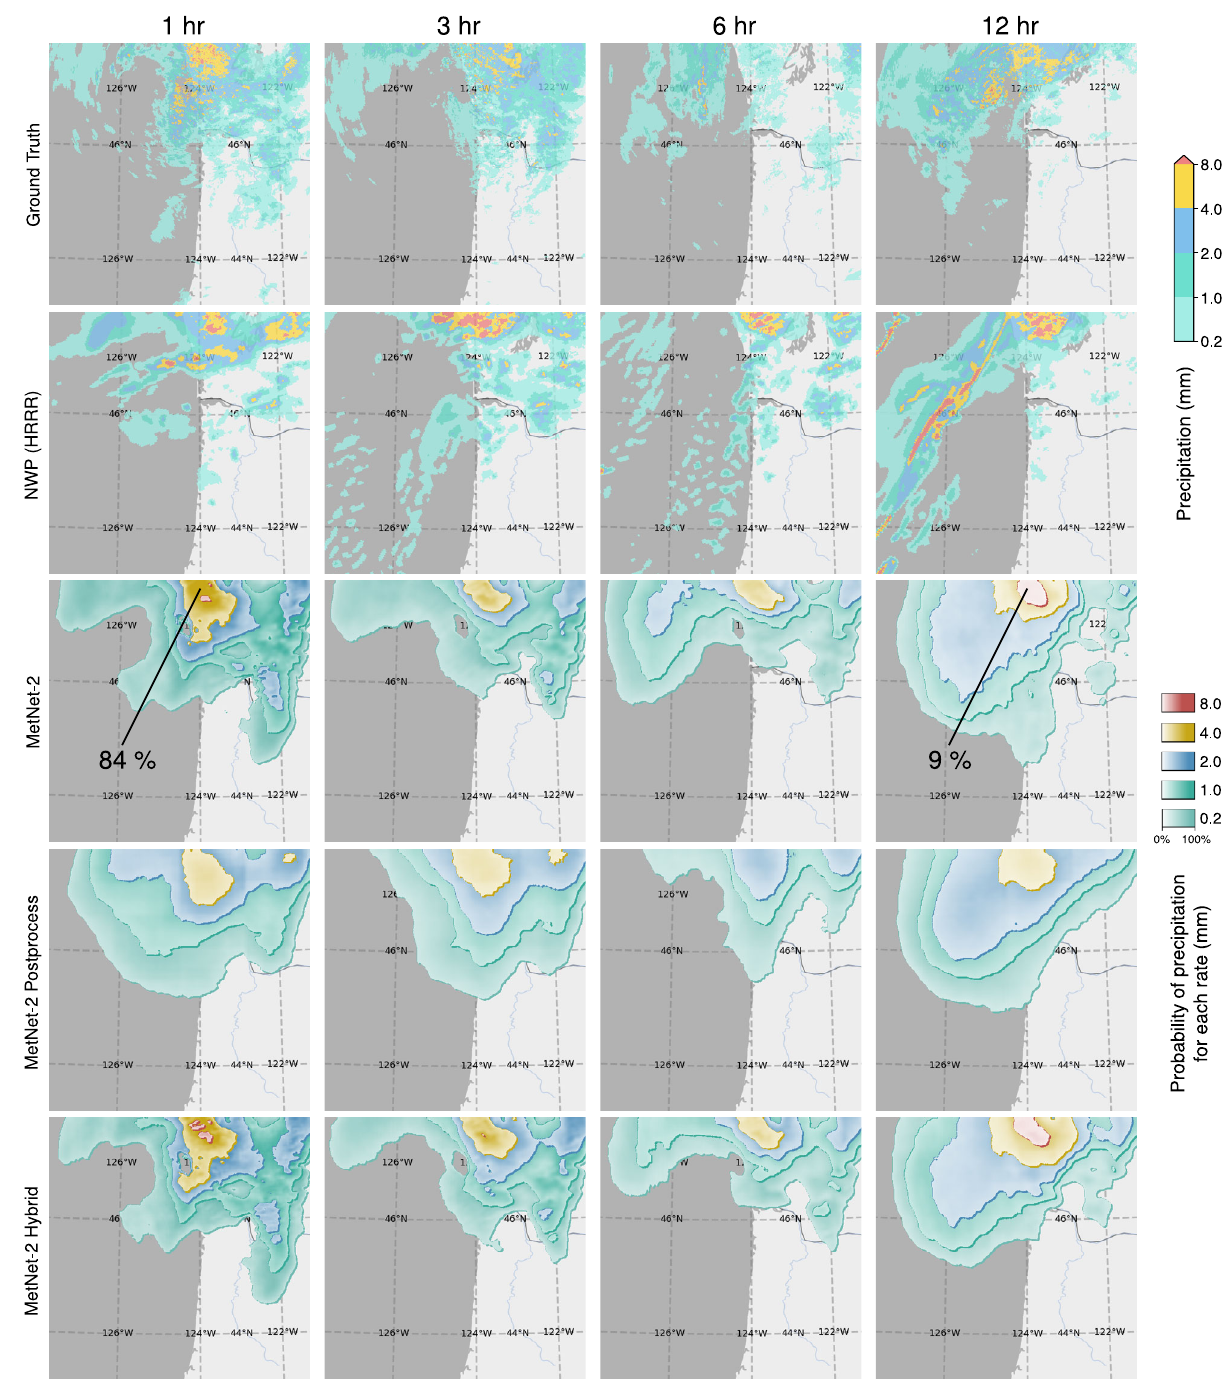
Fig. 6 | Case study for the models ’ forecasts of instantaneous precipitation. Case study for Thu Jan 03 2019 12:00 UTC of the North West coast of the US with forecastsofinstantaneousprecipitation.ForecaststhatuseMetNet-2arevisualized as3D-like contour plots. Each contour region corresponds to one of the visualised rates of precipitation of 0.2, 1.0, 2.0, 4.0, and 8.0mm/h. The color intensity within the contour region that corresponds to rate r is the probability of precipitation P( ≥ r ) that the respective model predicts. Only probabilities above the